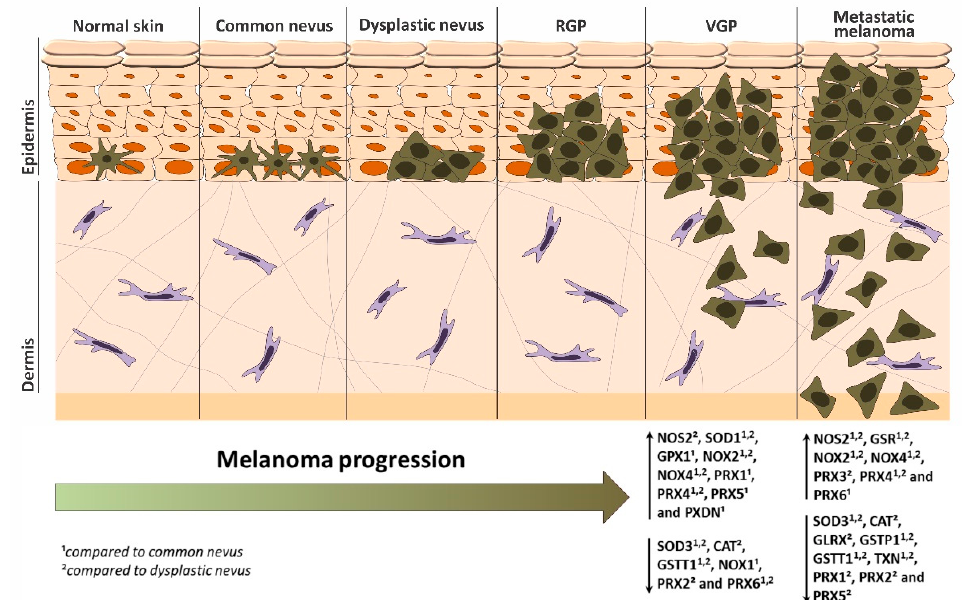
Figure 10. Expression of RNS/ROS-generating and detoxifying proteins in melanoma progression. Thin arrows indicate an increase ( ↑ ) or decrease ( ↓ ) of proteins in VGP and metastatic melanoma compared to ¹common nevus or ²dysplastic nevus. RGP: radial-growth phase. VGP: vertical-growth phase.